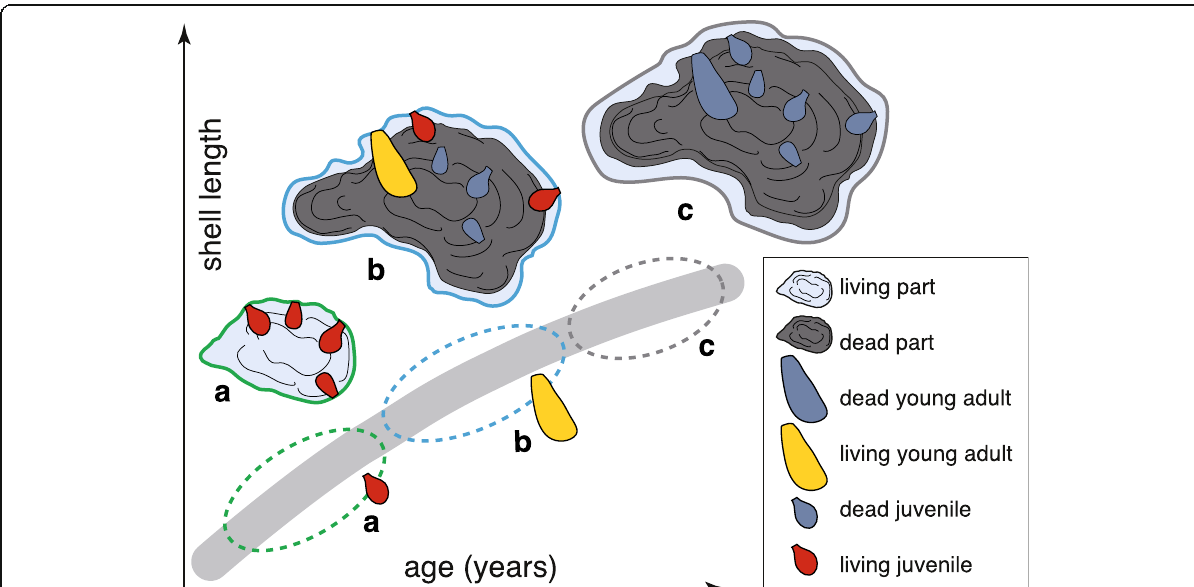
Fig. 11 Schematic summary of development and preservation of bivalve borings ( Gastrochaenolites ) in deep-water macroids and rhodoliths. a The juvenile bivalve growth rate is as rapid as the encrusting foraminiferal and coralline red algal growth rate. b In young bivalves, growth rate is higher than the host ’ s rate; these individuals cannot be embedded by the host and, therefore, die. c No adults are preserved unless phenotypic plasticity promoted small individuals. General growth curve of age-at-length boring bivalves after Bagur et al. (2013) and Peharda et al.